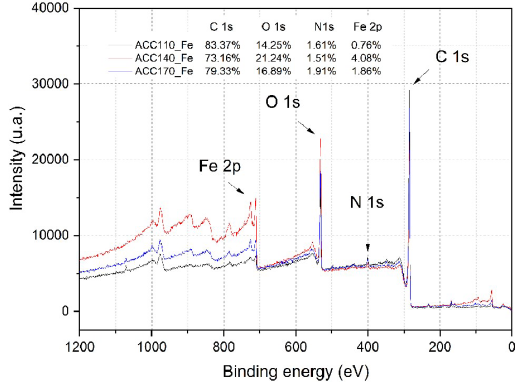
Figure 4. XPS survey spectra of the samples ACC110_Fe, ACC140_Fe, and